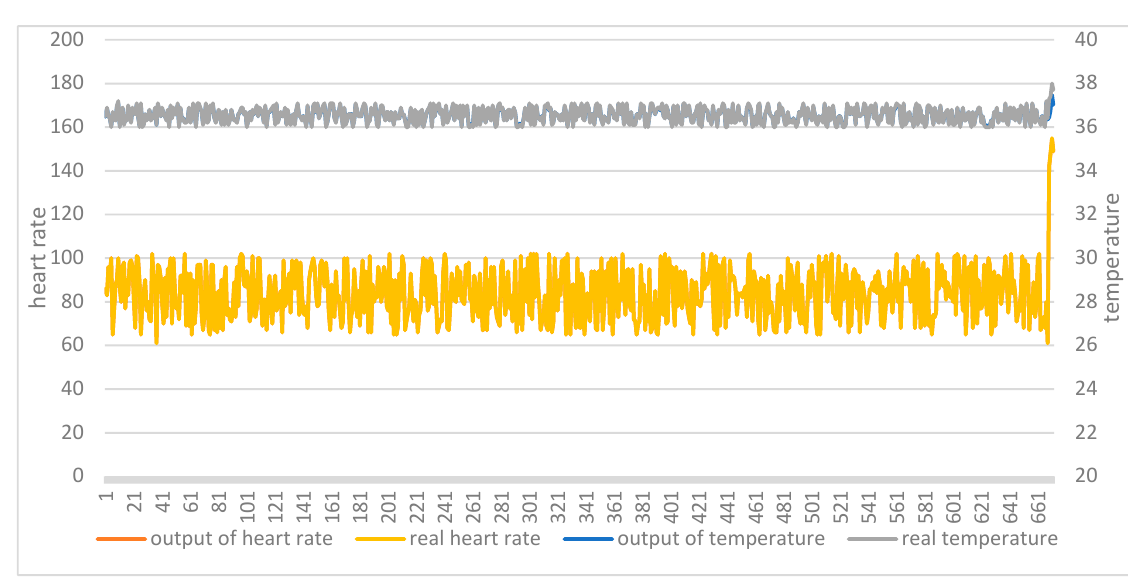
Figure 12. Comparison of input and output of AutoEncoder model in test set 1.